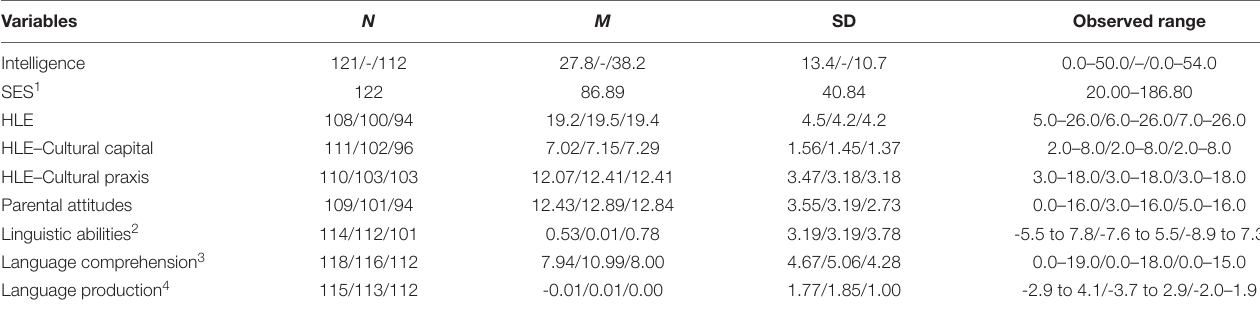
TABLE 1 | Descriptive statistics for the study variables at t1, t2, and t3 (sample sizes, means, standard deviations, observed ranges). Variables